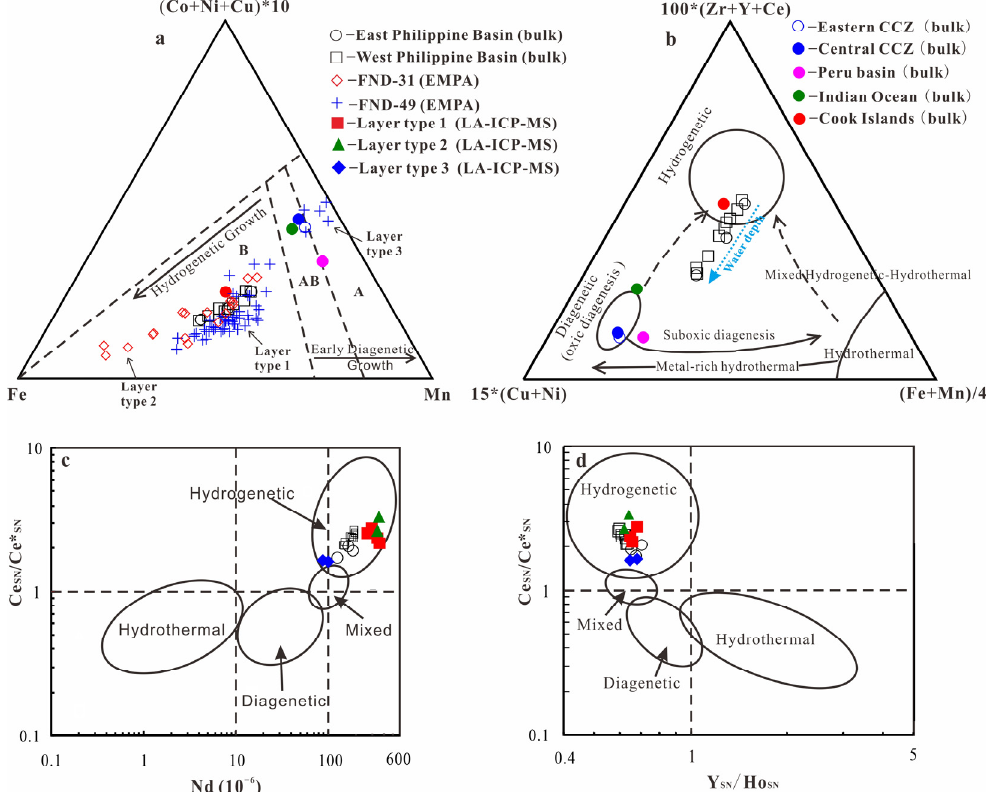
Figure 3. ( a ) Fe-Mn-(Cu + Ni + Co) × 10 diagram for genesis of Fe–Mn deposits from [24]. A: diagenetic, B: hydrogenetic, and AB: mixed type; ( b ) 15 × (Cu + Ni)-100 × (Zr + Y + Ce)-(Fe + Mn)/4 discrimination diagram for genesis of Fe–Mn deposits from [25]; ( c , d ) Discrimination diagrams based on geochemical relationships from [26]. Other data from the Clarion–Clipperton zone (CCZ), Peru Basin, Indian Ocean, and Cook Islands are from [1,19].